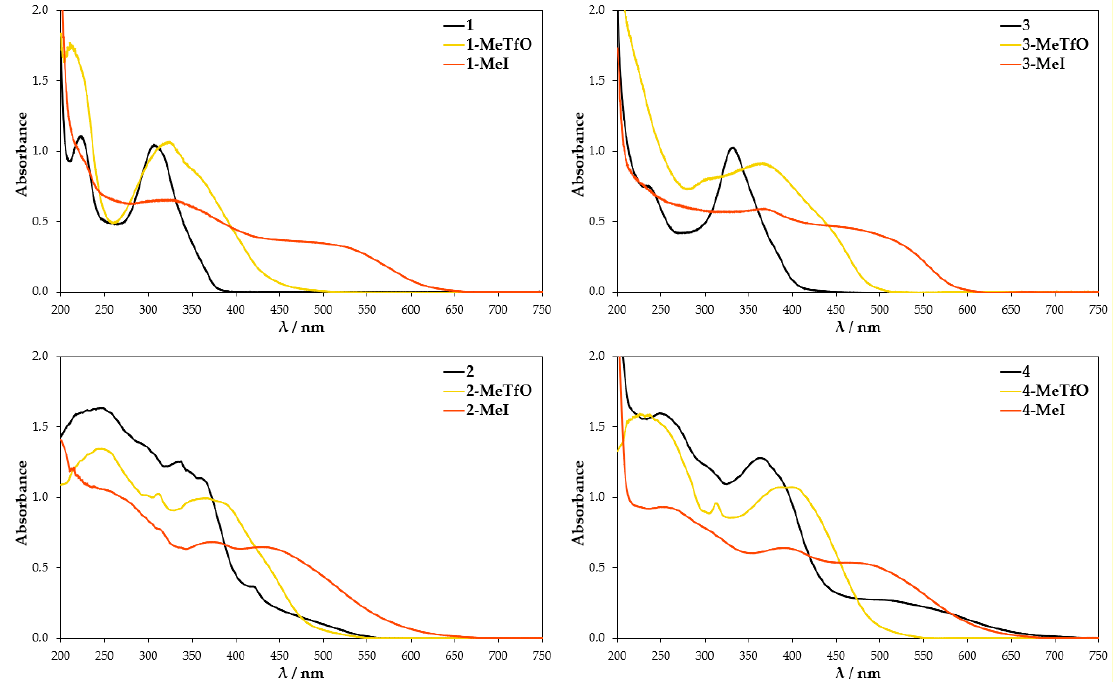
Figure 9. Absorption spectra of the compounds measured in KBr disks.